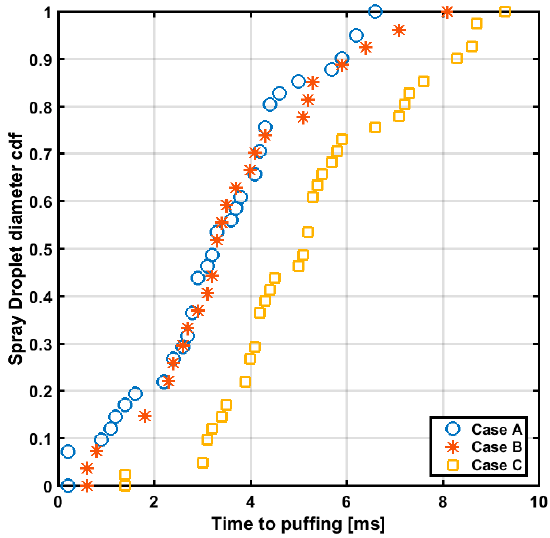
Figure 8. The empirical cumulative distribution function of dispersed water droplet size after the injection at 500 (A), 1000 (B), and 1500 bar (C) injection pressure versus time duration to puffing. As the injection pressured increased, the time to puffing was delayed.